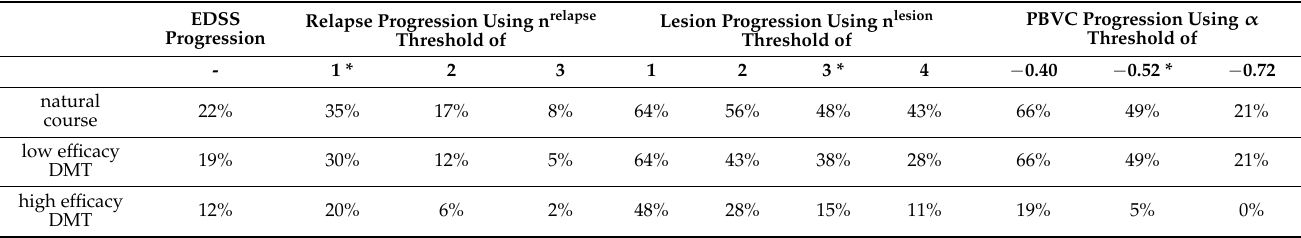
The * superscript indicates the selected